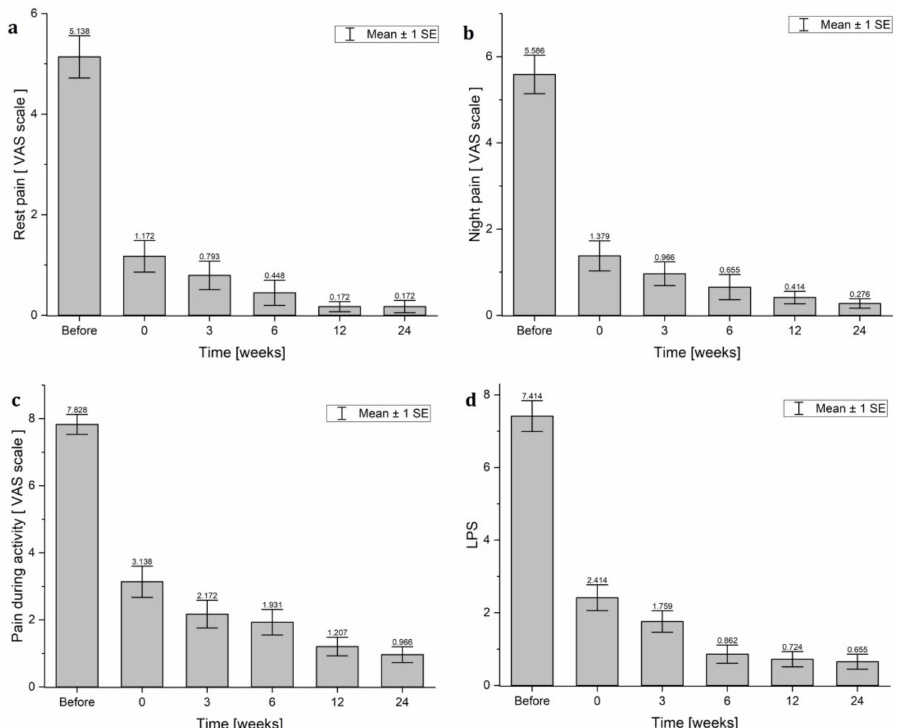
Figure 4. The comparison of changes in VAS points: ( a ) rest pain; ( b ) night pain; ( c ) pain during activity) and ( d ) LPS scores in the HVES group: before treatment; 0—after treatment; and 3, 6, 12, and 24 weeks after study